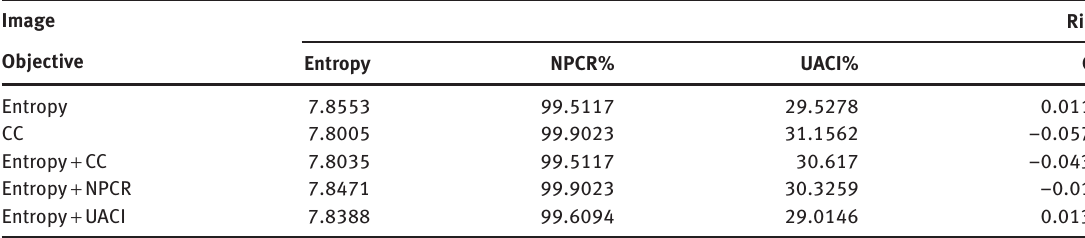
Table 5: Comparative Analysis for Rice Image Using Transformed Logistic Function. Image